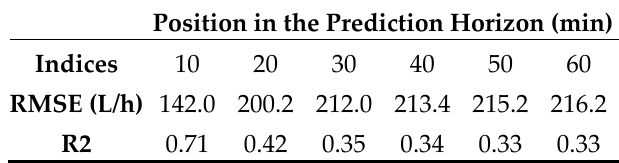
Table 1. Performance indices over an hour-long prediction